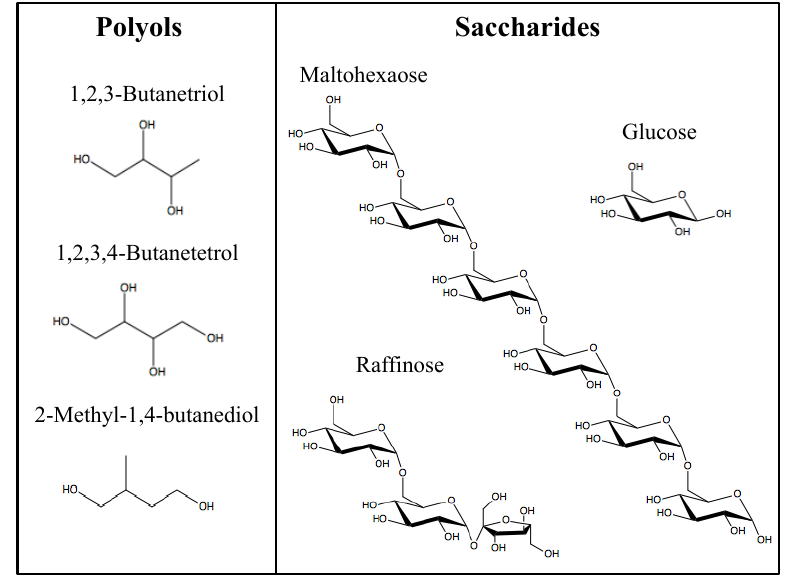
Figure 1. The structure of the polyols and saccharides studied experimentally in this